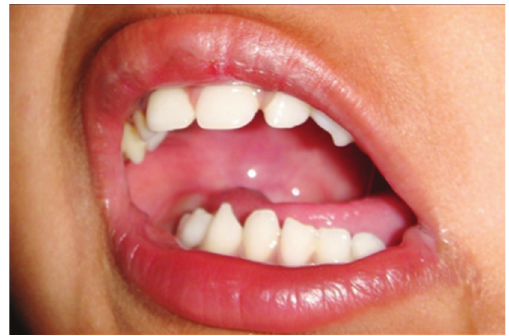
Figure 2: Deviated and restricted mouth